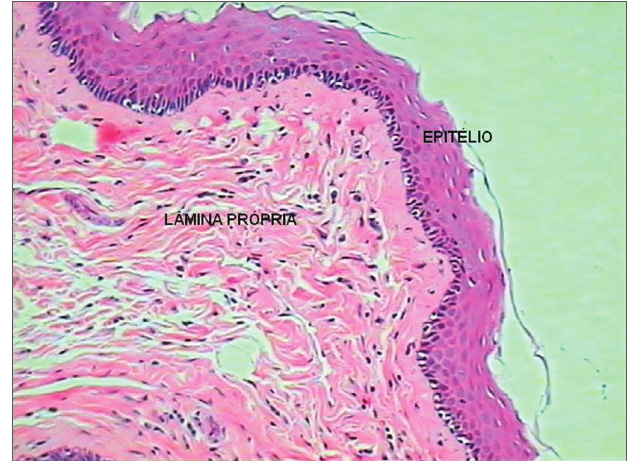
Figura 5. Corte histológico coronal da prega esquerda (controle) de um animal com sacrifício após 90 dias. Coloração hematoxilina- eosina. Observamos a lâmina própria com infiltrado linfomonuclear leve (aumento de 200x). Quadro 1. Análise quantitativa do processo inflamatório em 6